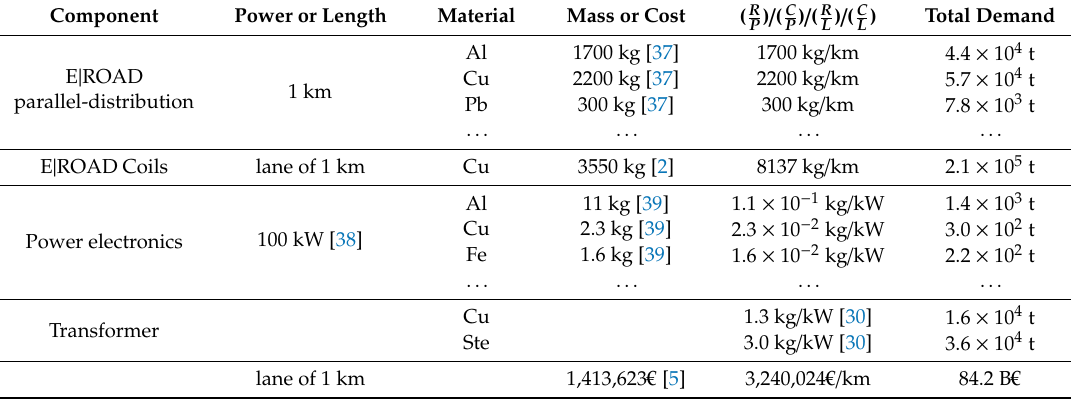
Table A2. Exemplary raw material and investment demand for IPTEV infrastructure (E | ROAD) for